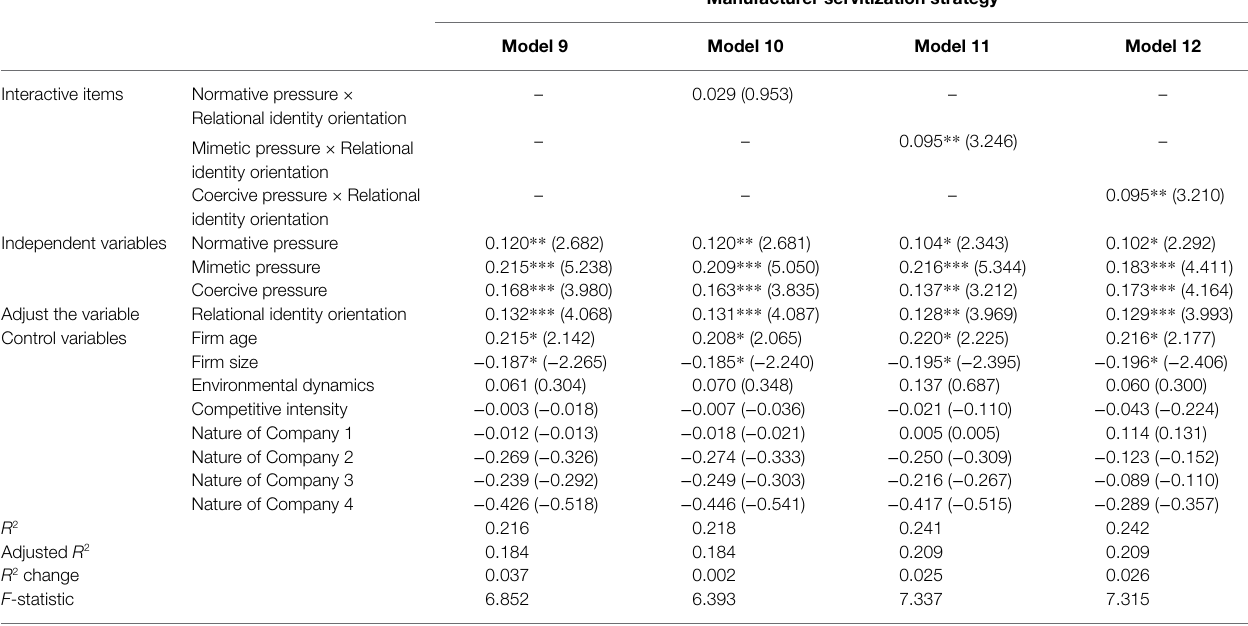
TABLE 7 | The moderating effect of relational identity orientation.